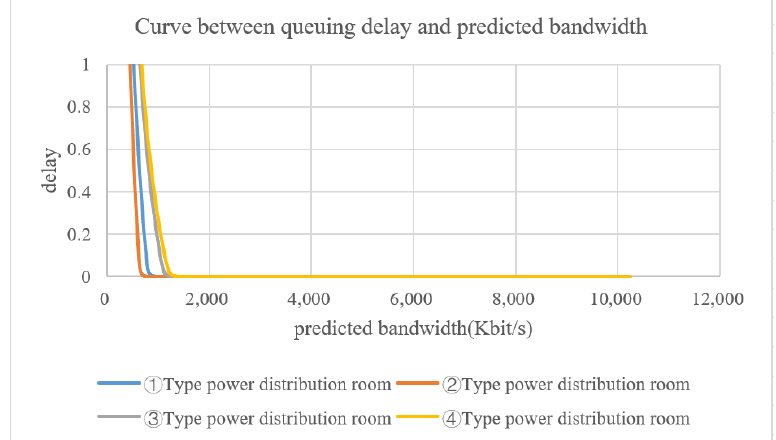
Figure 9. Curve between queuing delay and predicted bandwidth.